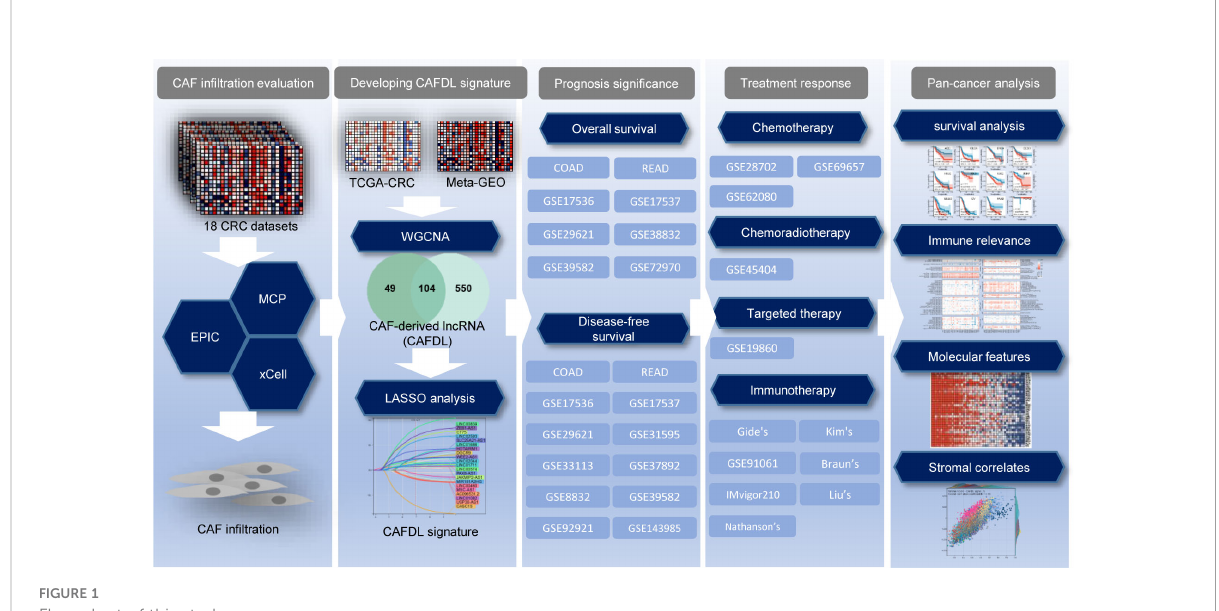
FIGURE 1 Flow chart of this